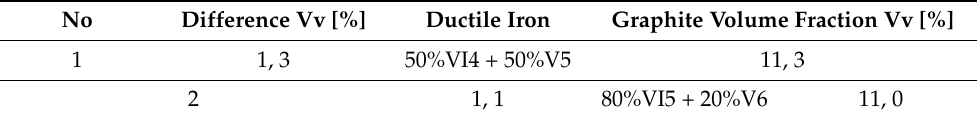
Table 5. Summary of the results obtained by the CT